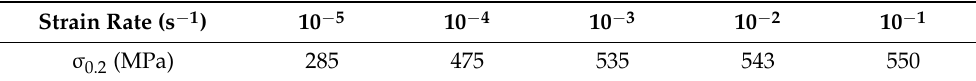
Figure 31. Engineering stress − strain compression curves of TaNbHfZrTi alloy at 1073 K under different strain rates. Reprinted with permission from ref. [50]. Copyright 2012 Springer Nature. Table 4. The yield strength ( σ 0.2 ) of TaNbHfZrTi alloy determined with different strain rates at 1073 K. Adapted from ref.